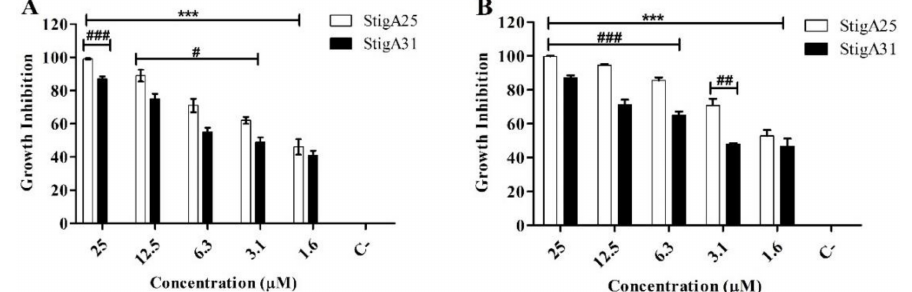
Figure 10. Antiparasitic activity of StigA25 and StigA31 on trypomastigote forms of T. cruzi after 12 h ( A ) and 24 h ( B ) of incubation. Negative control is represented by C-. Values represent mean ± SD ( N = 3). *** p ≤ 0.0001 compared to the positive control. ### p ≤ 0.0001, ## p ≤ 0.001 and # p ≤ 0.01 compared between the analogs StigA25 and StigA31 at the same concentration. Statistical analysis was performed using ANOVA followed by Tukey test.